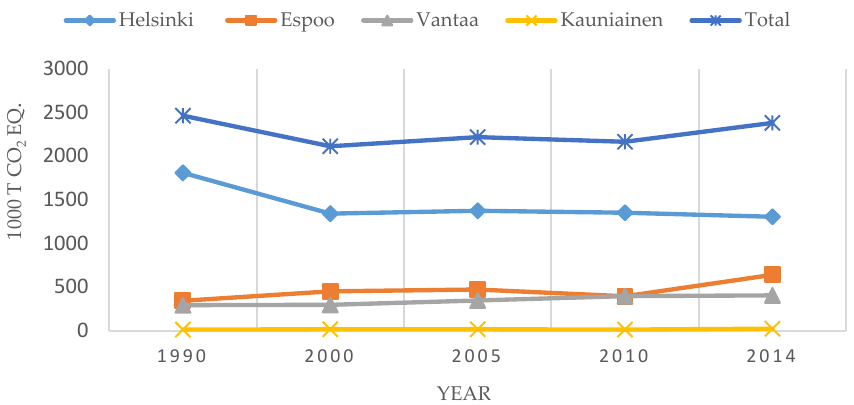
Figure 6. District heating emissions in the cities of the Helsinki metropolitan area